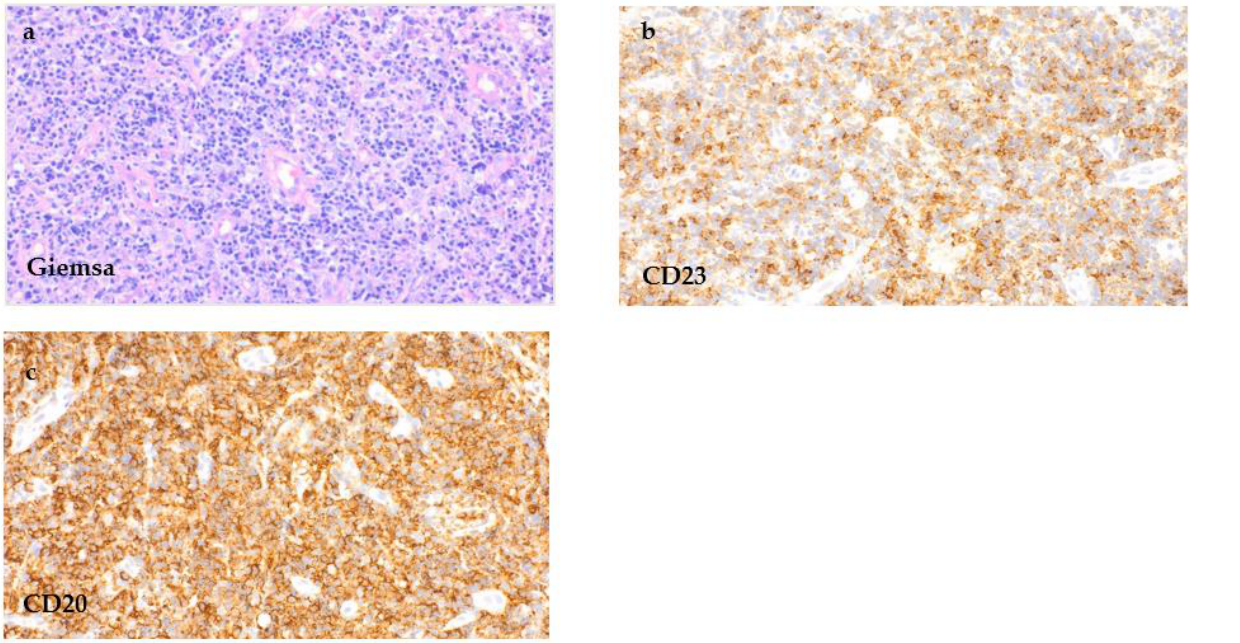
Figure 5. CLL/SLL infiltration of the lymph node. Tissue samples of the removed cervical lymph node, showing a dense cell infiltrate of small lymphocytes (( a ), H&E staining, 400×) with a co- expression of CD5 (( b ), 400×), CD20 (( c ), 400×), CD23 (( d ), 400×) and CD79a (( f ), 400×). CD30 (( e ), 400×) remained negative, and only single small EBV-positive bystander cells were seen in EBER in situ hybridization (( g ), 400×). 3. Material and Methods The PubMed database was searched from 1 January 1993 to 8 April 2022 with the key words “Epstein Barr virus”, “EBVMCU”, “mucocutaneous ulcer”, “head and neck ulcer” and “EBVMCU head and neck” to identify all EBV-MCU cases of the head and neck region published so far. All cases published about an EBV MCU in the indicated period were included into the following review without exclusion criteria. A total of 181 cases were identified.